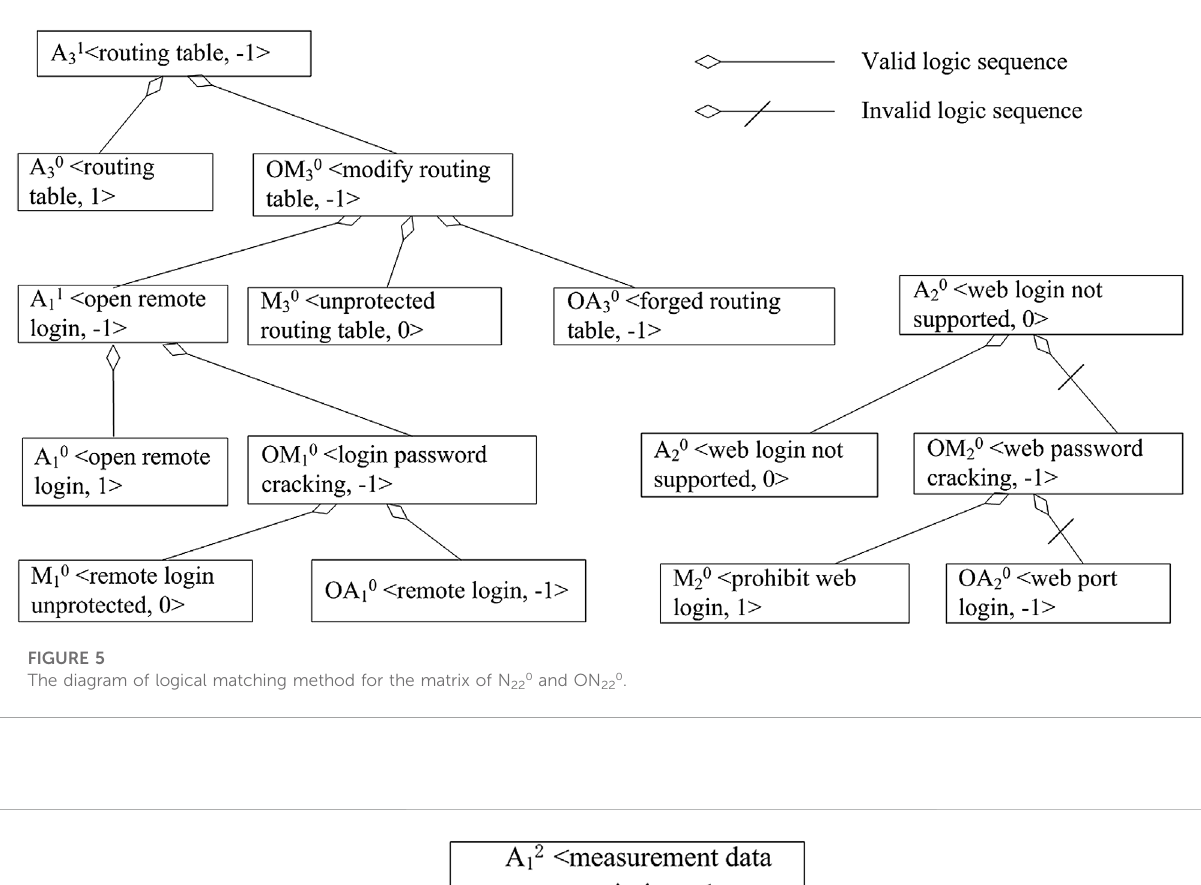
FIGURE 5 The diagram of logical matching method for the matrix of N 22 0 and ON 22 0 .